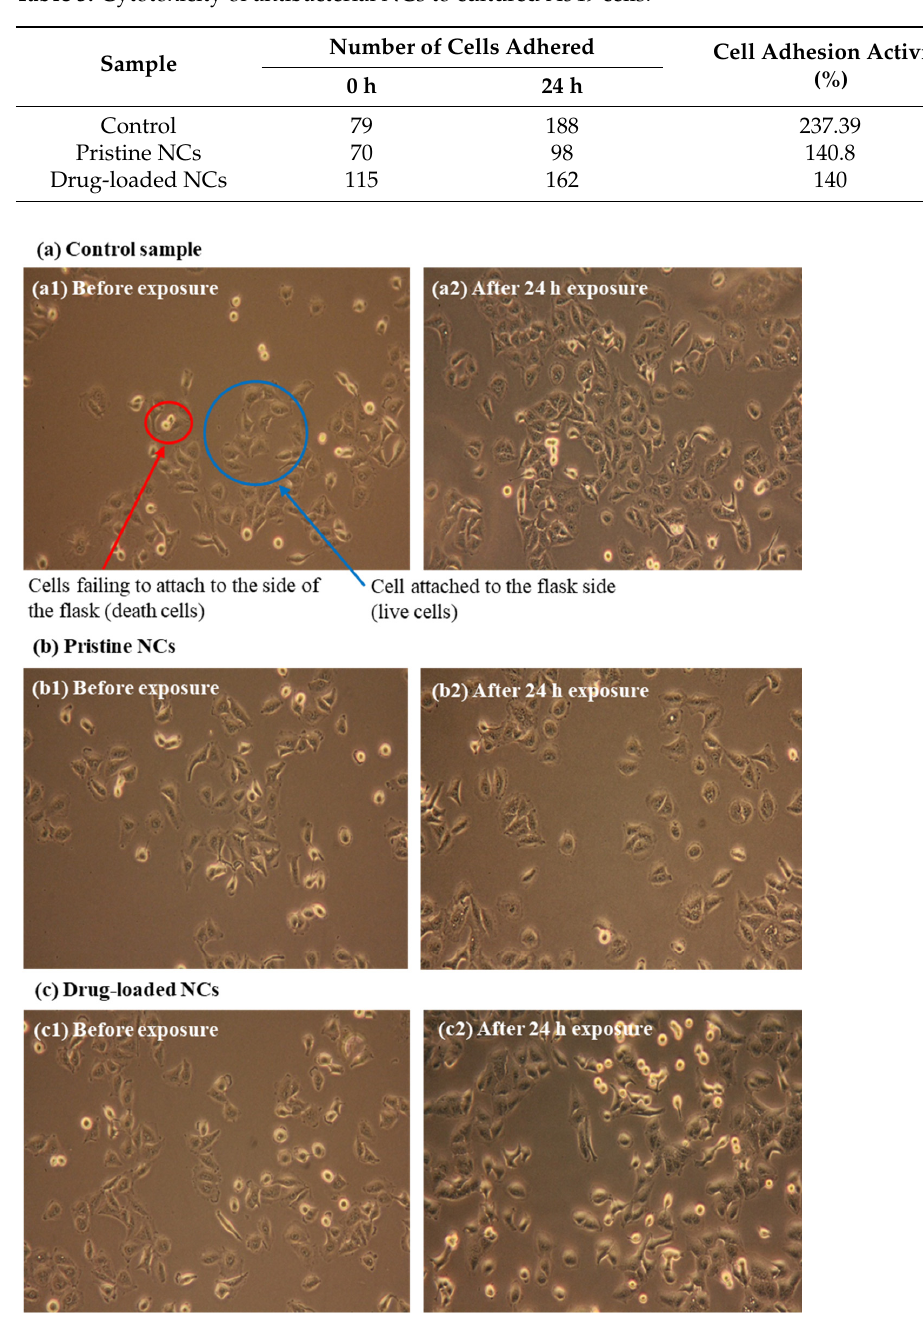
Figure 9. Antibacterial activity of ligand-brush NCs: ( a ) C.S., ( b ) pristine NCs, and ( c ) drug-loaded NCs.